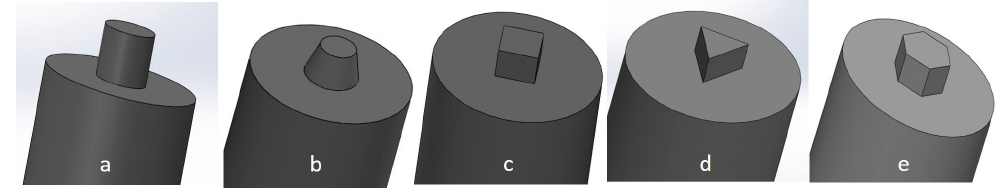
Figure 5. FSW tools with different pin profile ( a ) cylindrical; ( b ) tapered cylindrical; ( c ) triangular; ( d ) square and ( e ) hexagonal.